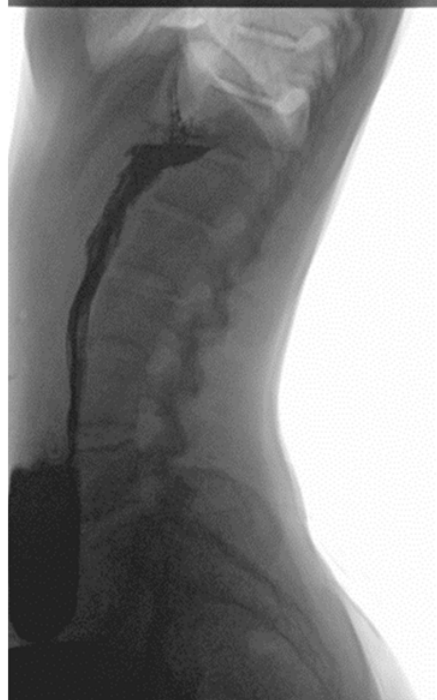
Figure 2. The greater curve of the stomach is displaced downward, below the level of the iliac crest. Lateral view in upright position.